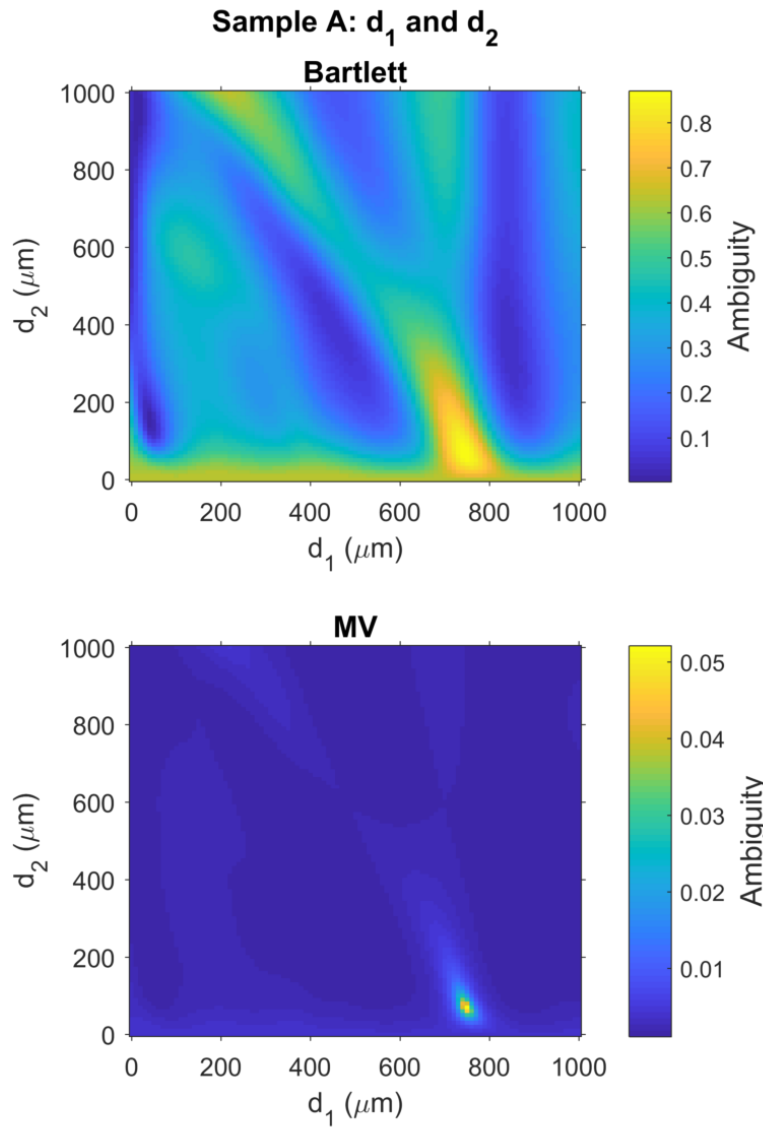
Figure 5. Matched field ambiguity surfaces provide estimates for the thickness of the polycarbonate layer, d 1 and the air gap, d 2 , as illustrated in Figure 1 with layer thickness for Sample A given in Table 1. ( Top ) Bartlett processor has a global maximum d 1 = 750 µ m and d 2 = 70 µ m; ( Bottom ) MV processor has a global maximum d 1 = 750 µ m and d 2 = 70 µ m. These results are consistent with ground truth measurements with a Vernier caliper. See Table 2 for a comparison of measurement errors for layers in all